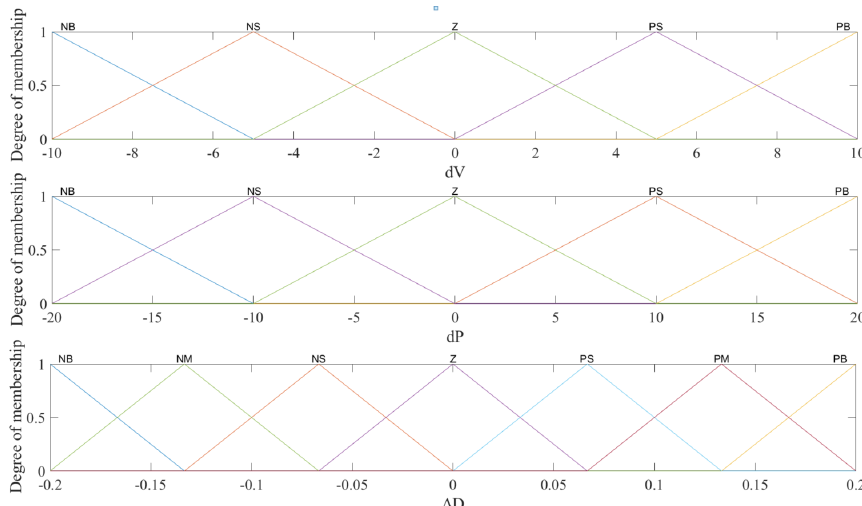
Figure 6. FLC membership